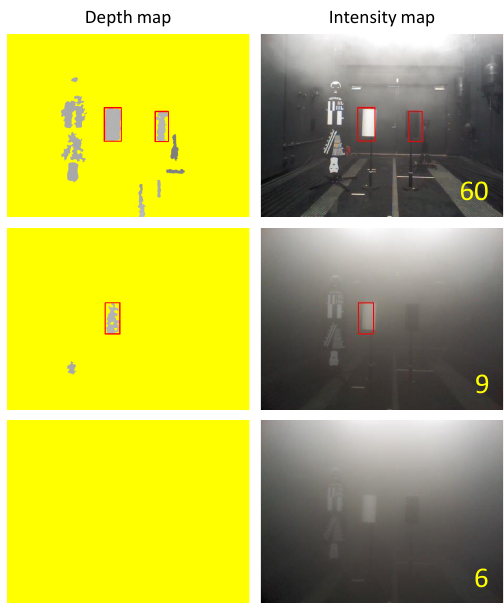
Figure 16. Experiment results by the emulated ESPE sensor, Kinect.